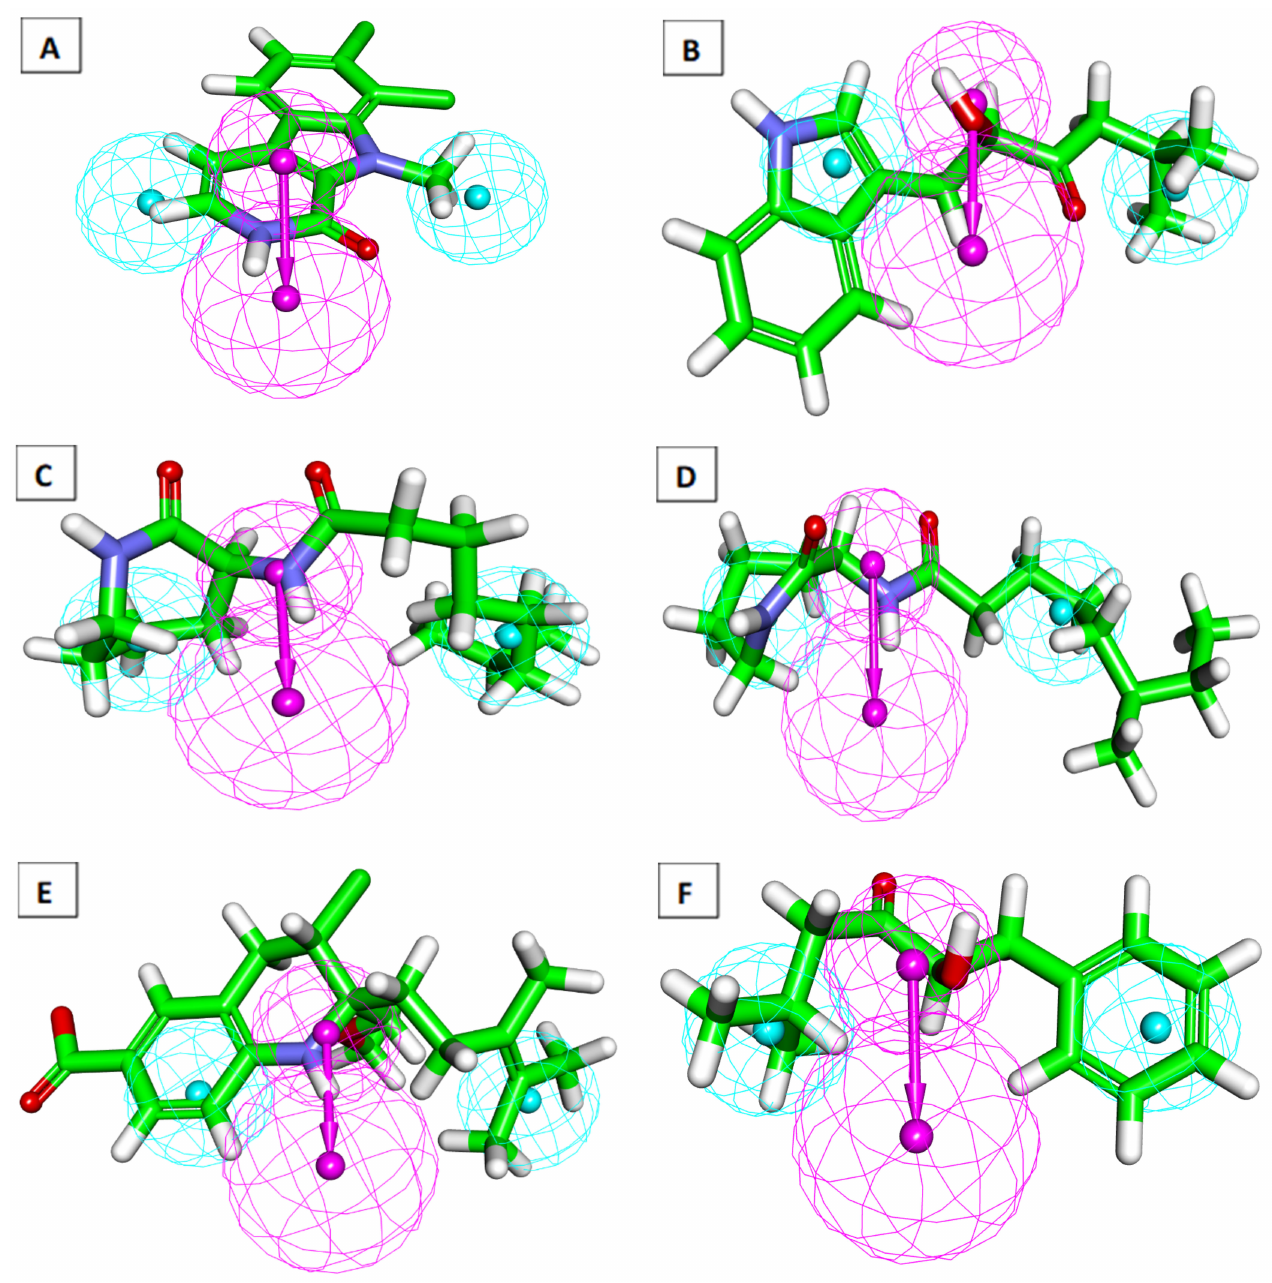
Figure 6. Mapping of the tested metabolites on the generated pharmacophore. ( A ) metabolite 236 (fit value = 0.523), ( B ) metabolite 291 (fit value 2.887), ( C ) metabolite 292 (fit value = 2.890), ( D ) metabolite 293 (fit value = 2.587), ( E ) metabolite 303 (fit value = 2.867), and ( F ) metabolite 305 (fit value =